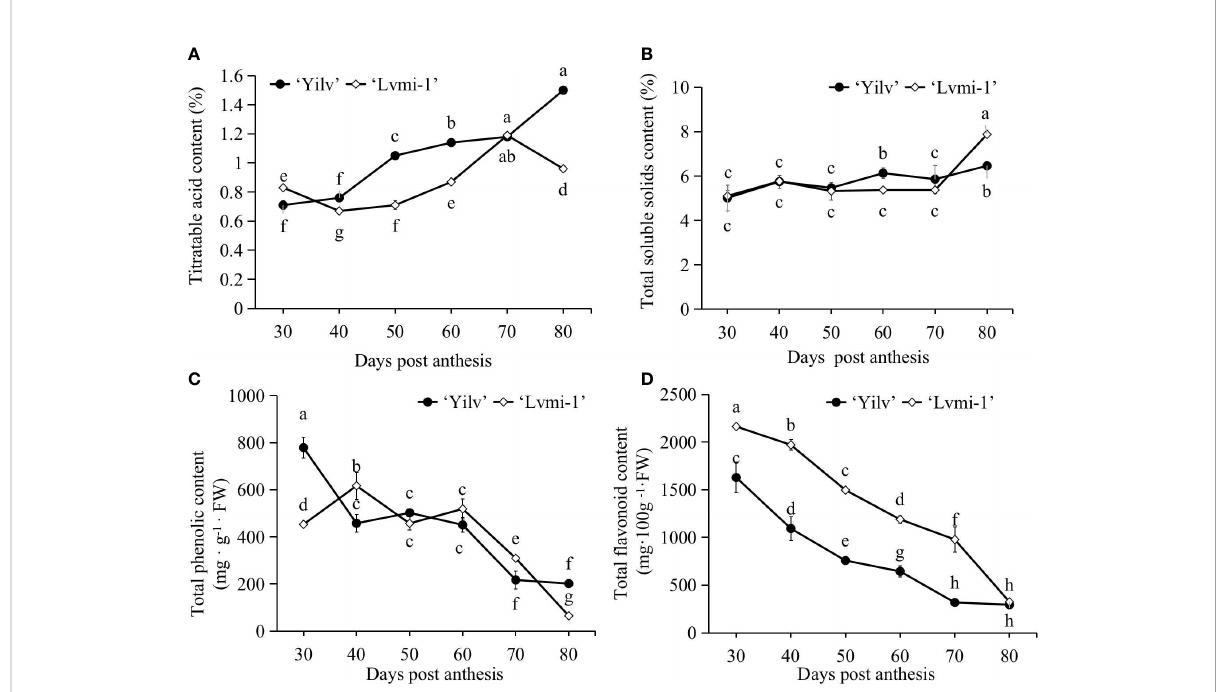
FIGURE 2 Changes of conventional nutrient contents in ‘ Yilv ’ and ‘ Lvmi-1 ’ fruits during fruit development and maturity. (A) Titratable acid content changes during fruit development. (B) Total soluble solid content changes during fruit development. (C) Total phenolic content changes during fruit